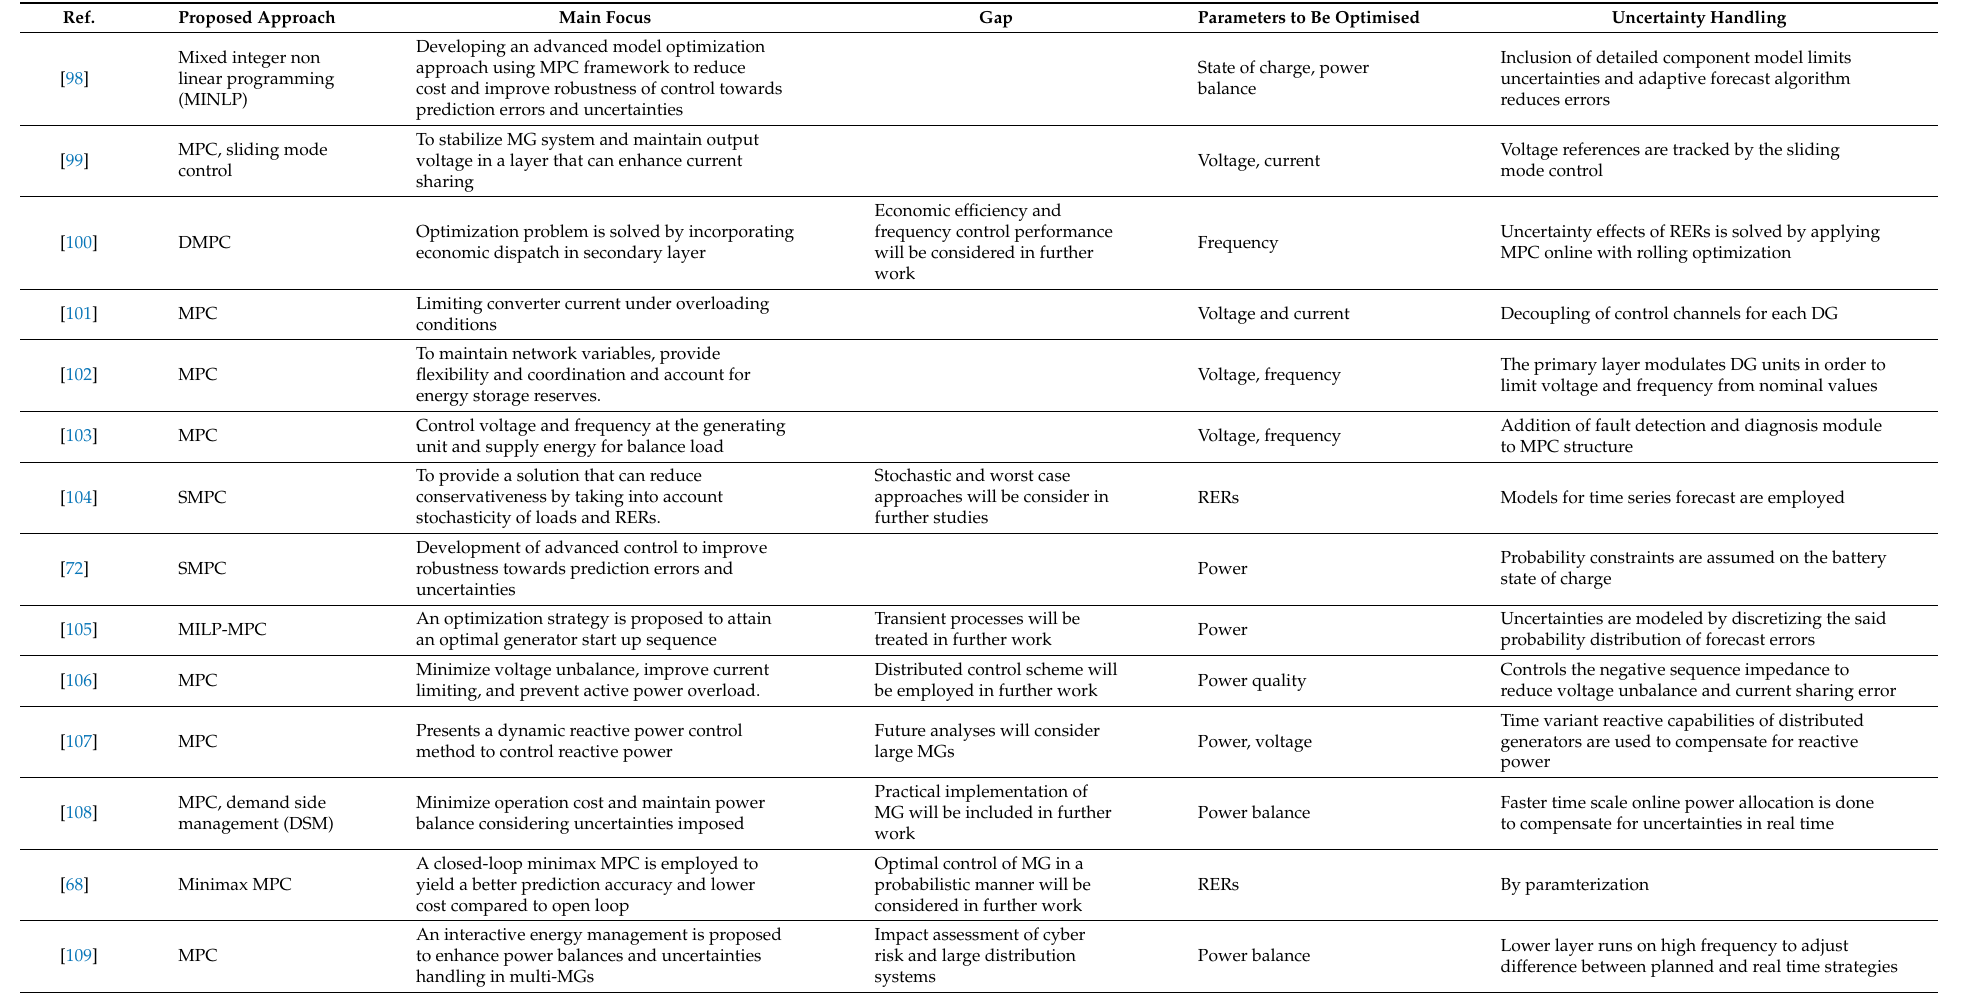
Table 3. Summary of recent MPC applications to islanded